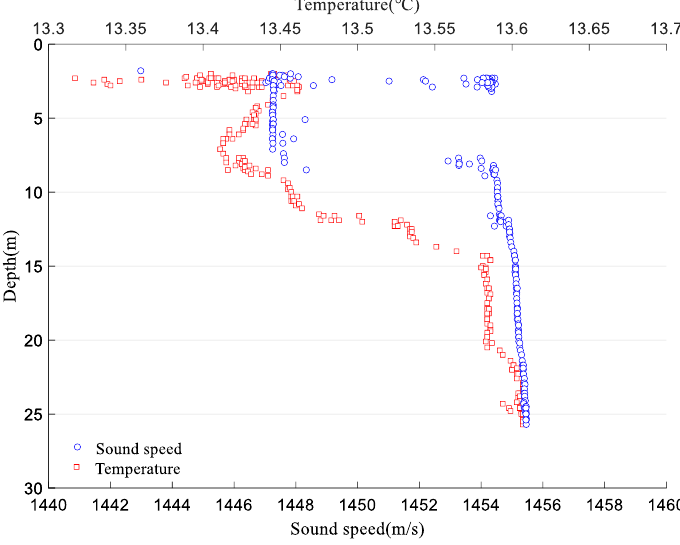
Figure 5. SVP (depth, sound velocity, and temperature). The attitude information of the measuring ship over time can be obtained through POSMV as shown in Figure 6.